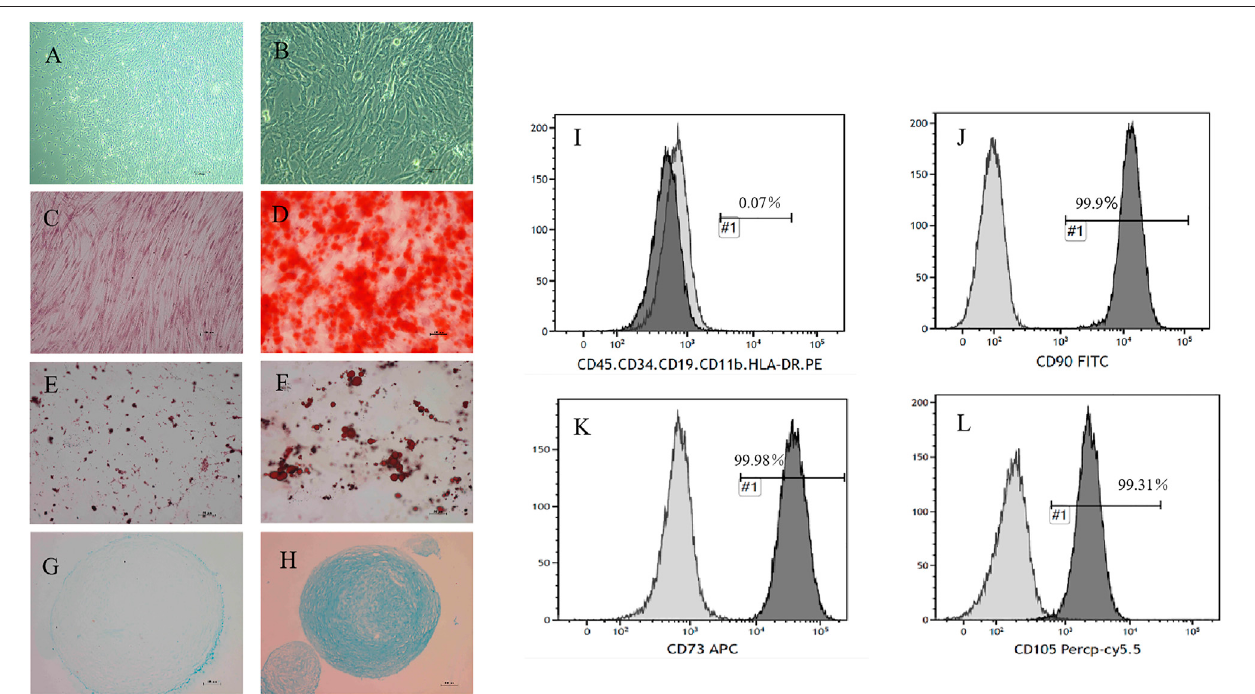
FIGURE 1 | Morphology and phenotype identi fi cation of UC-MSC. The morphology of UC-MSC is shown at ×50 magni fi cation (A) or at ×200 magni fi cation (B) . (C,D) UC-MSC weresuccessfullydifferentiated intoosteoblasts, whichwere veri fi ed byAlizarin Redstaining.Representativephotos weretaken ofthecontrol group (C) and the induction group (D) at ×100 magni fi cation. (E,F) UC-MSC were successfully differentiated into adipocytes through oil red “ O ” staining. Representative photos weretakenofthecontrolgroup (E) andtheinductiongroup (F) at×200magni fi cation. (G,H) UC-MSCweresuccessfullydifferentiatedintothecartilagecells,which wereidenti fi edbysimplebluedye.Representativephotosweretakenofthecontrolgroup (G) andtheinductiongroup (H) at×100magni fi cation.Thesurfacemarkersof UC-MSC, including CD90, CD105, CD73, CD45, CD34, CD11b, CD19, and HLA-DR, were analyzed by fl ow cytometry. Among them, the positive rates of CD90, CD105, and CD73 were above 99%. Others were almost always negatively expressed (I – L) .